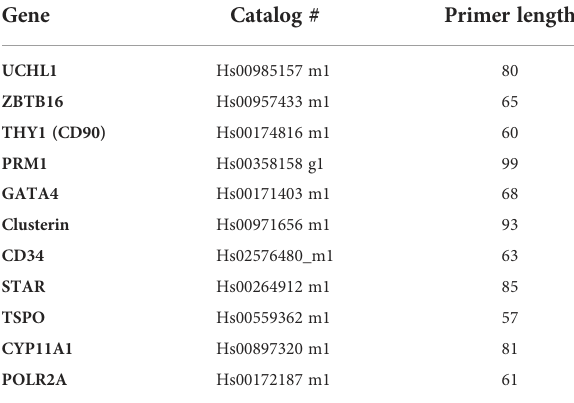
TABLE 2 Taqman assay primers used for PCR.